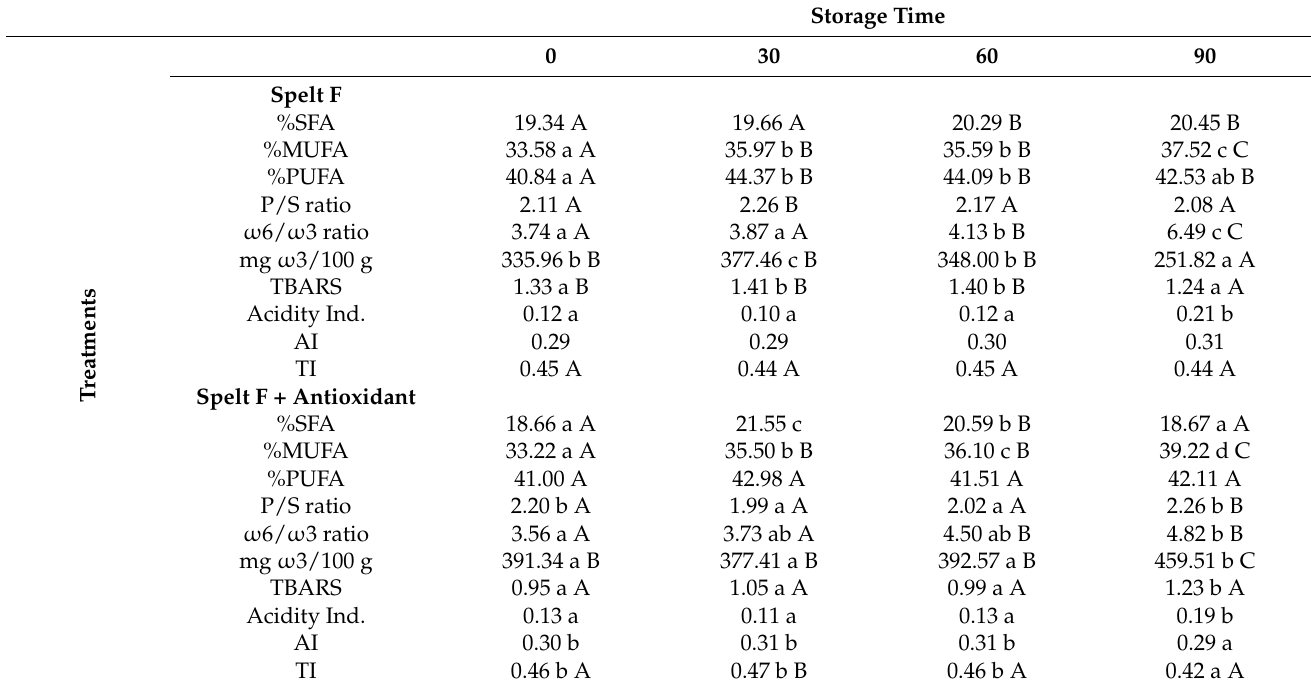
Table 5. Chemical indices and ratios for spelt